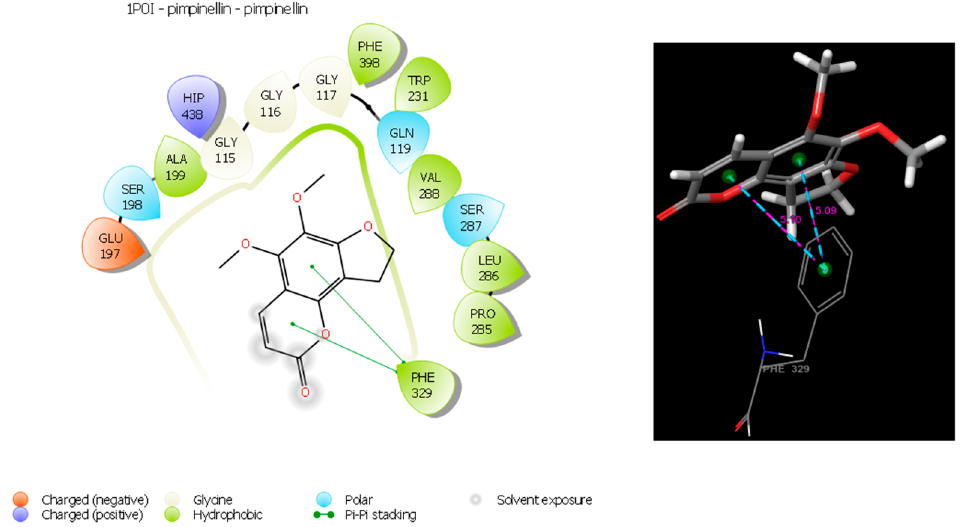
Figure 3. Schematic representation of main interaction of umbelliferone with AChE (1-EVE). Green color represents hydrophobic interactions, light blue represents polar interactions, blue represents positively charged residues, red represents negatively charged residues.